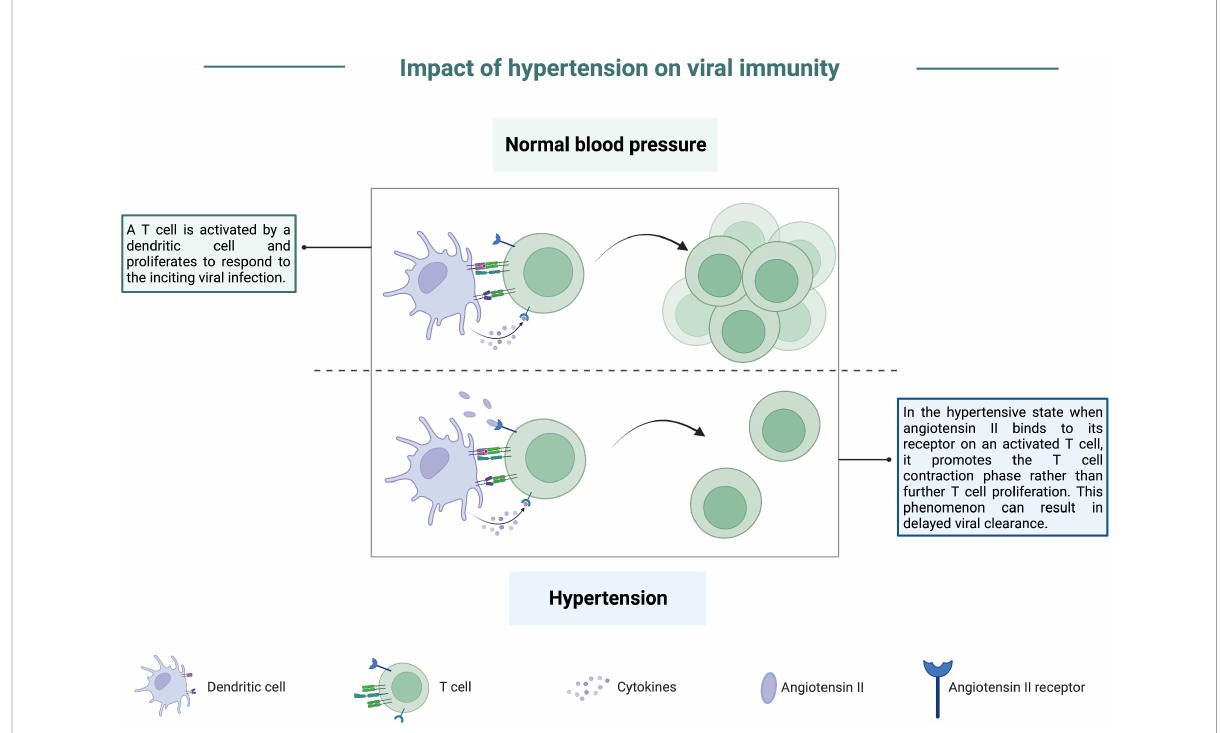
FIGURE 7 Impact of hypertension on viral immunity. In a state of normal blood pressure levels, T cells can be activated and proliferate to respond to virally infected cells following antigen presentation by a dendritic cell. However, in the hypertensive state, angiotensin II levels are higher, and this protein can bind to its receptor present on activated T cells. Upon binding, angiotensin II promotes the T cell contraction phase at the expense of sustaining a robust effector response. This phenomenon can result in delayed viral clearance due to a lack of T cells counteracting virally infected